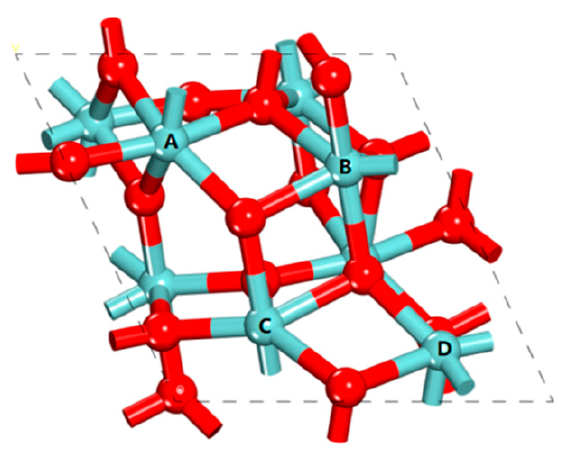
Figure 2. Four surface Zr atoms ( A , B , C and D ) with different coordination environments on the monoclinic ZrO 2 (111) surface.